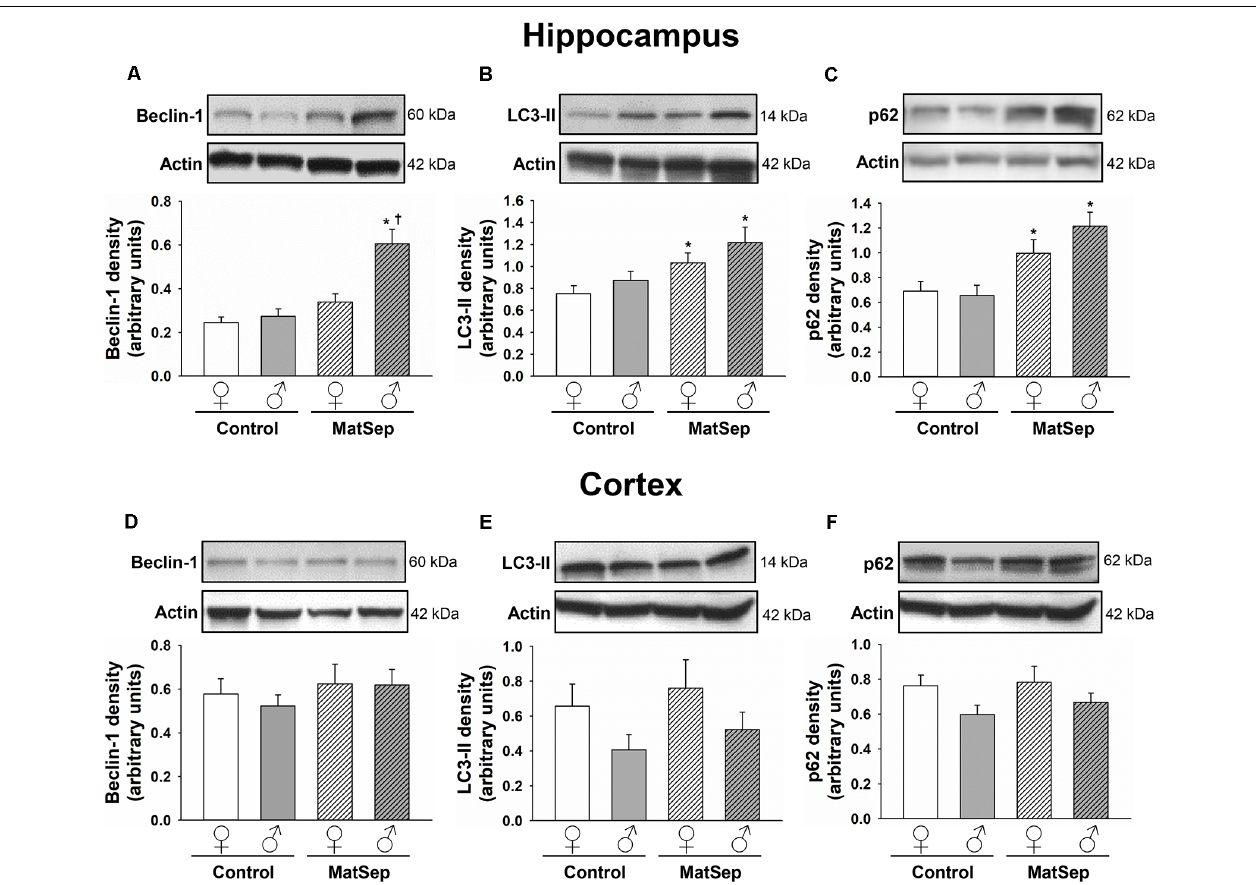
FIGURE 2 | Immunoblot analysis of ALP markers from hippocampal and cortical homogenates from adult rats subjected to MatSep. Panels above each graph show representative blots for (A,D) beclin-1, (B,E) LC3-II, and (C,F) p62. Bar graphs represent densitometric analysis of protein expression normalized to actin and averaged over at least three separate blots. * p ≤ 0.05 vs. same-sex Controls; † p ≤ 0.05 when comparing between